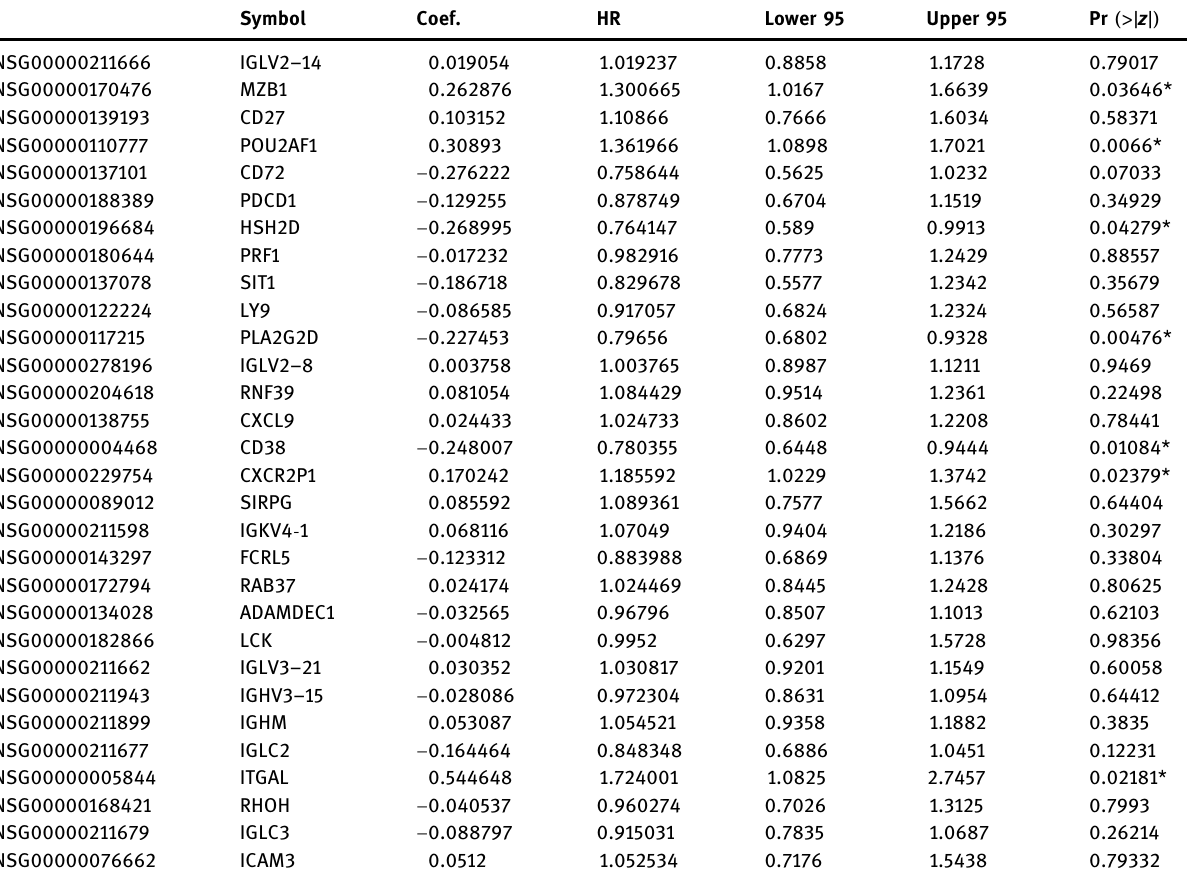
Table 2: Results of multivariate Cox regression analysis of top30 genes Symbol Coef.